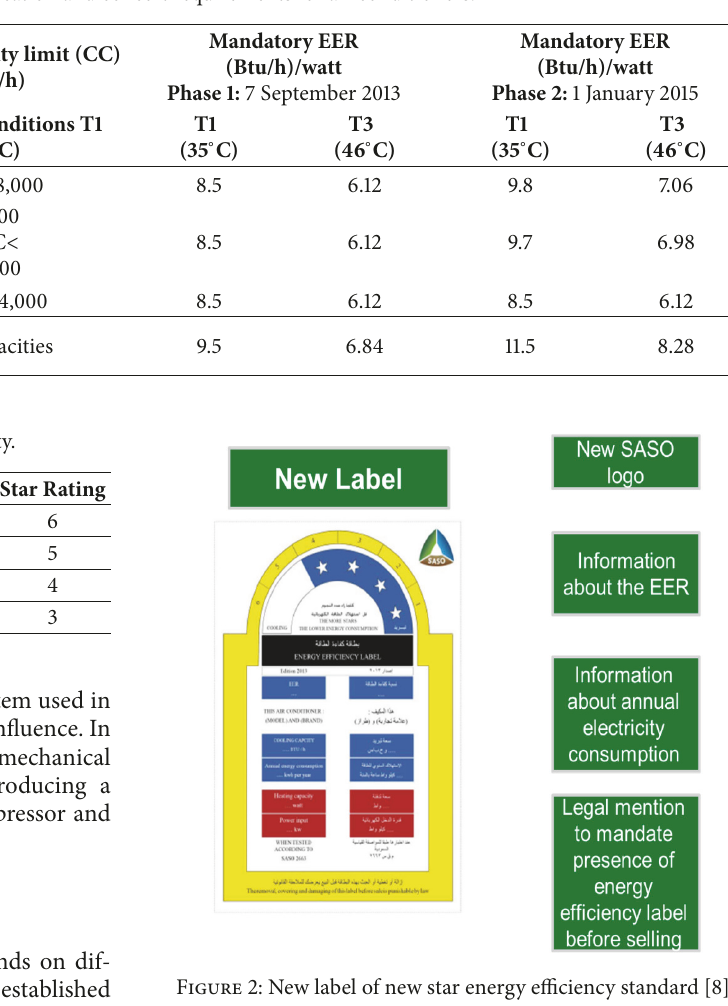
Table 2: Energy classification and concert requirements for air conditioners.